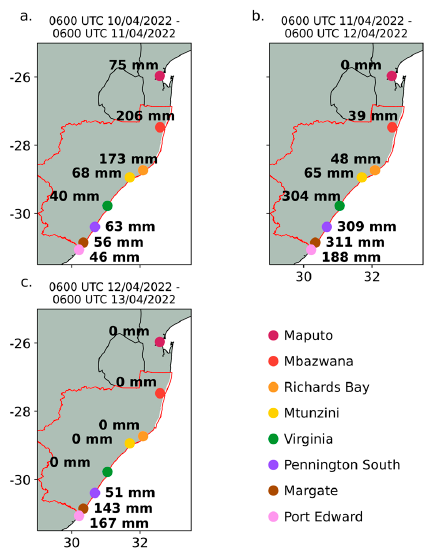
Figure A1. South African Weather Service daily rainfall values for stations within KZN from ( a ) 10 April 2022; ( b ) 11 April 2022 and ( c ) 12 April 2022. Note that the data is accumulated over a 24 h period starting at 0600 UTC on the given day through to 0600 UCT the following day (see title of panel). The data for the Maputo station, which is accumulated from 0700 UTC to 0700 UTC, is provided by INAM.